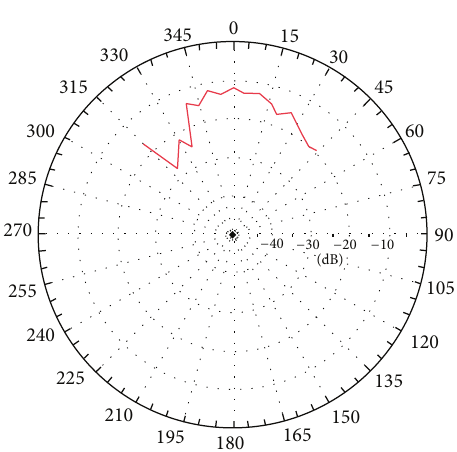
Figure 15: Vertical cut of 3D measured radiation pattern at